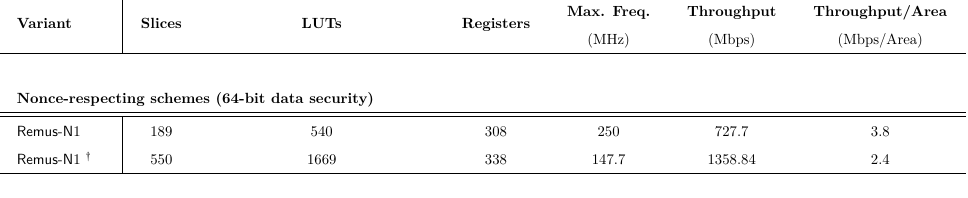
Table 4: FPGA Results for Remus and Romulus on the Xilinx Virtex 6 FPGA using ISE Variant Slices LUTs Registers